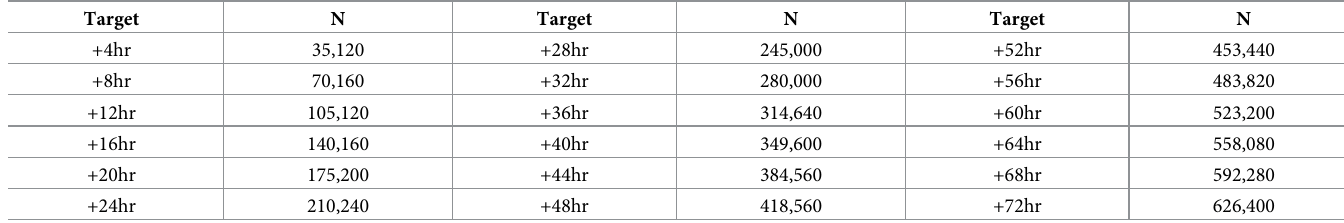
Table 1. Sample size (N) summary for hourly (+hr)